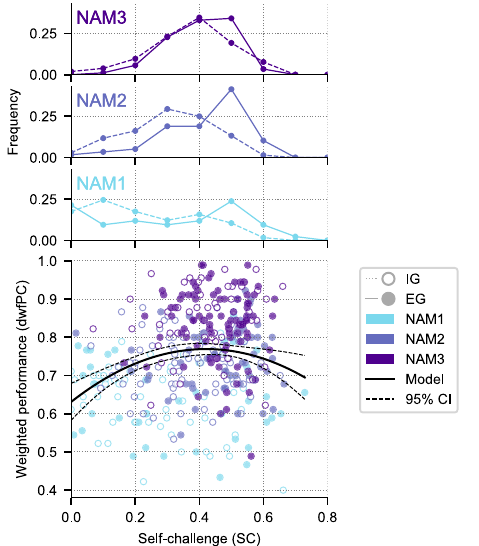
Fig. 4 Relationship between activity choices and fi nal performance. The scatter plot shows the dif fi culty-weighted fi nal score (dwfPC; y -axis) as a function of the self-challenge index (SC; x -axis). Each point is one participant. Colors indicate the number of activities mastered: NAM1, N = 99 ( N = 42; N = 57); NAM2, N = 126 ( N = 58; N = 68); and EG IG EG IG NAM3, N = 140 ( N EG = 88; N IG = 52); fi lled and un fi lled circles indicate, respectively, EG ( N = 188) and IG ( N = 177) groups. The black curve shows the line of best fi t from a linear-quadratic regression model, with 95% con fi dence intervals represented by the strip surrounded by black dashed lines. The marginal histograms on the top show the distributions of SC scores for each NAM (color) and group (solid and dashed traces). SC was higher for EG relative to IG groups in participants who mastered only 1 or 2 activities (NAM1 and NAM2), and was equivalent, with intermediate values, for participants who mastered all 3 activities (NAM3; top histogram). Source data are provided as a Source Data fi